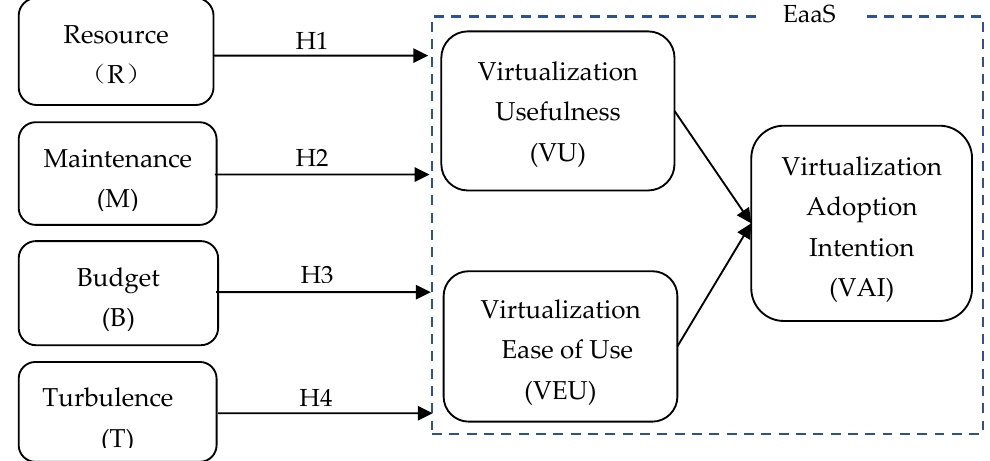
Figure 2. Proposed Conceptual Framework.